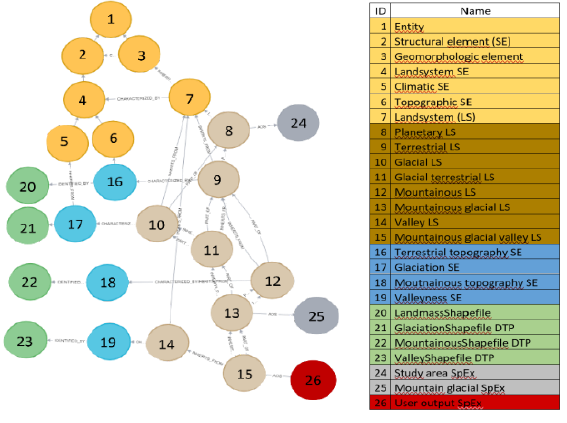
Figure 6: Portion of the User’s Graph DB